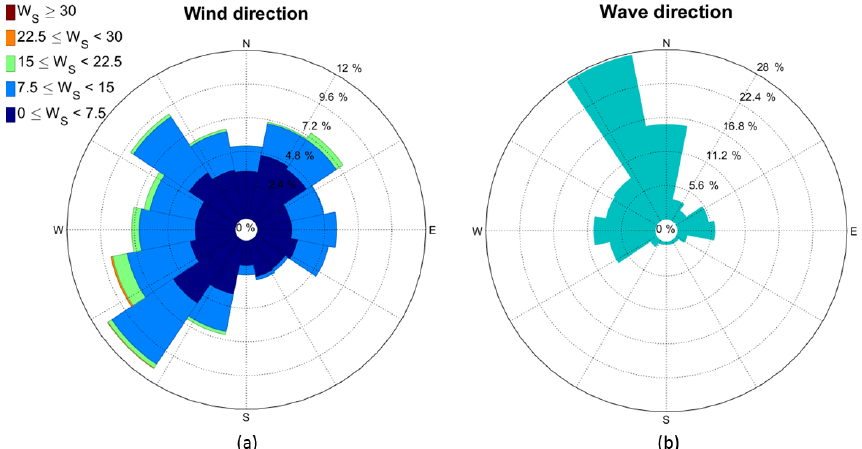
Figure A2. (a) The wind rose is shown excluding the wind shadow zones at z = 40m or z = 15m depending on the measurement campaign, while in (b) the peak wave direction is shown. Data correspond to the FINO1 measurement mast during the year 2010 for z = 40m (5470 measurement points) and 2015–2016 for z = 15m (3510 measurement